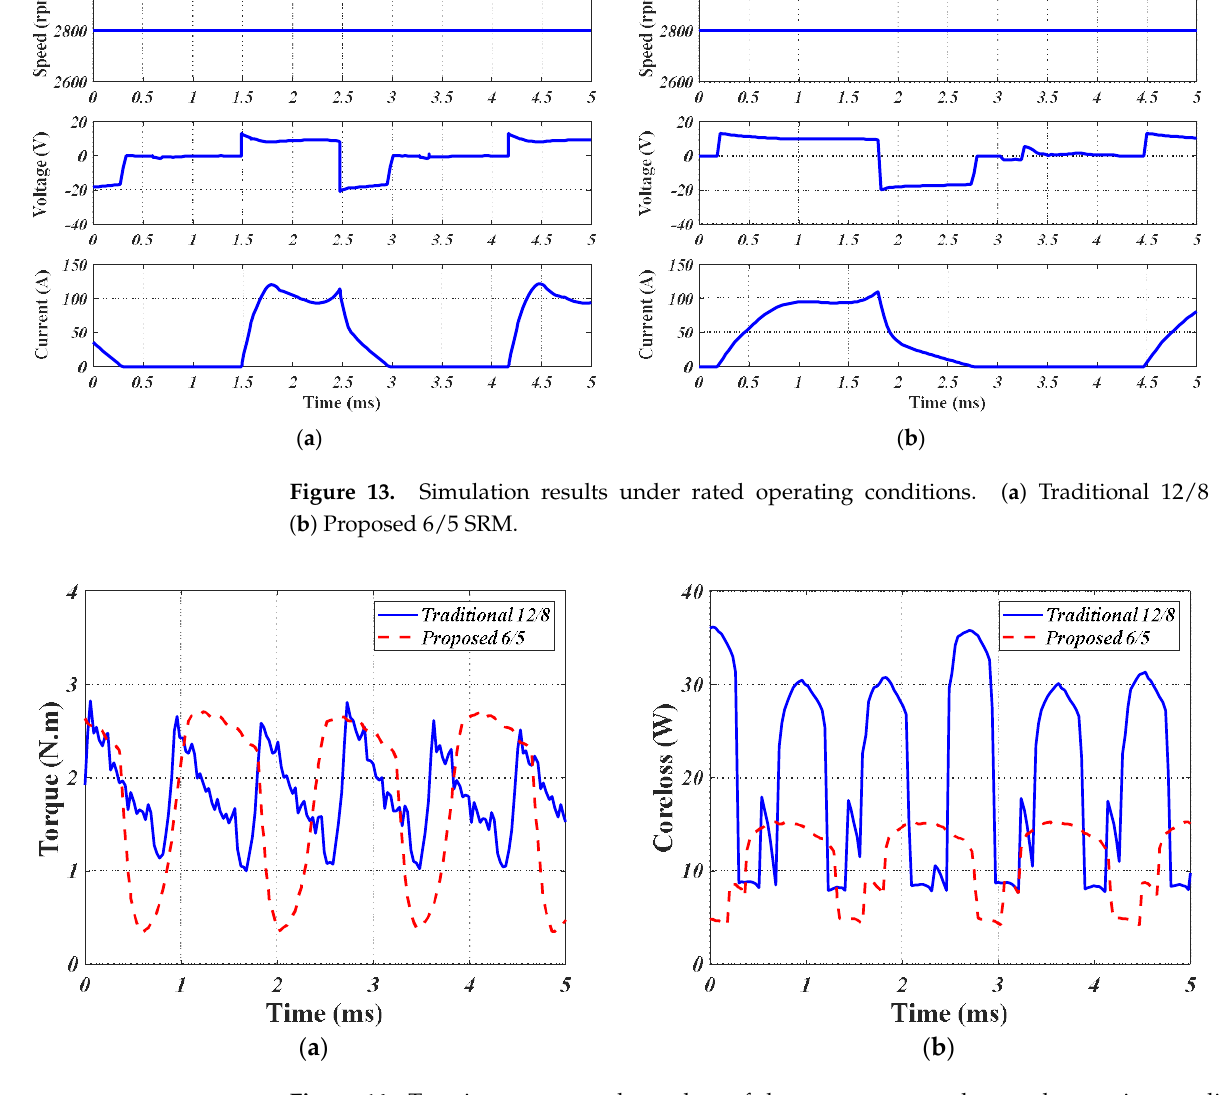
Figure 14. Transient torque and core loss of the two motors under rated operating conditions. ( a ) Transient torque; ( b ) Transient core loss.